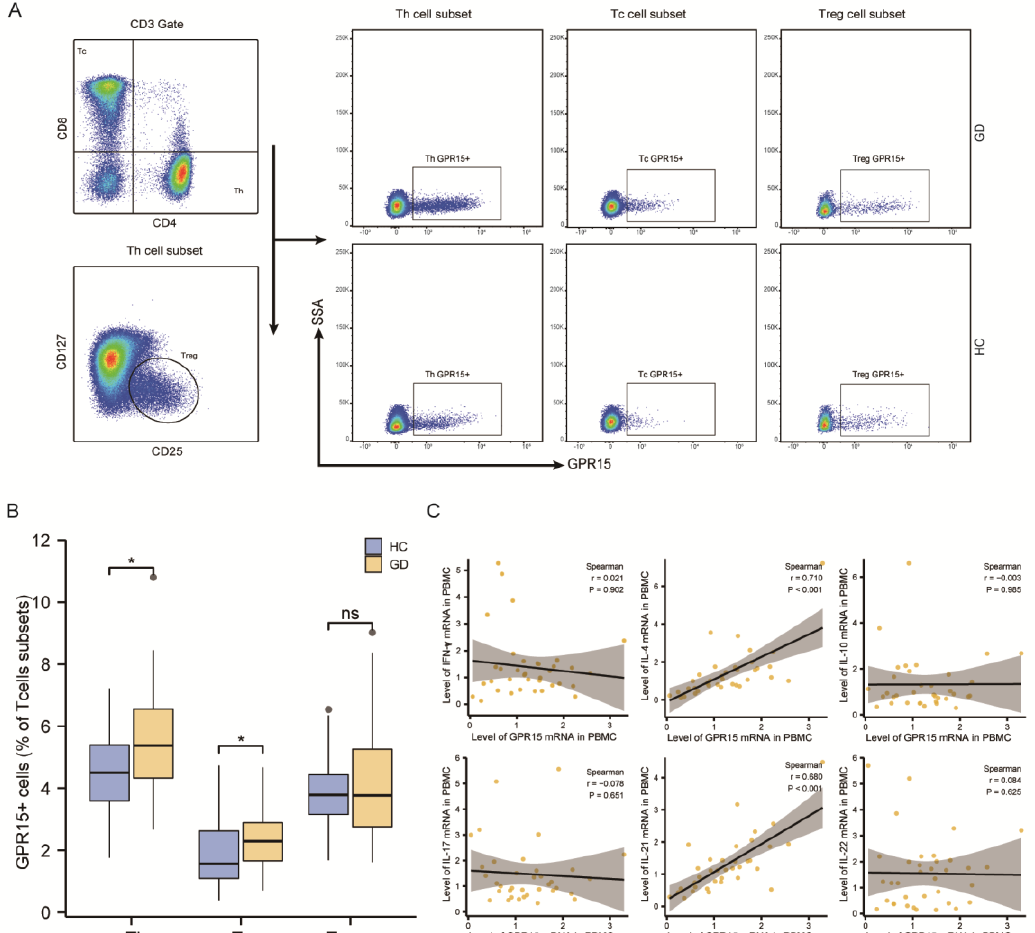
Figure 2. The frequency of GPR15+ cells increased on specific subsets of PBMCs from GD patients, and its expression positively correlated with IL-4 and IL-21. ( A ) Typical flow cytometry plots and gating for T cells subsets. ( B ) Statistical analysis of flow cytometry results in ( A ). ( C ) Correlations of GPR15 and cytokines expression in PBMCs from GD patients. (ns, p ≥ 0.05; *, p < 0.05; HC: healthy controls, GD: Graves’